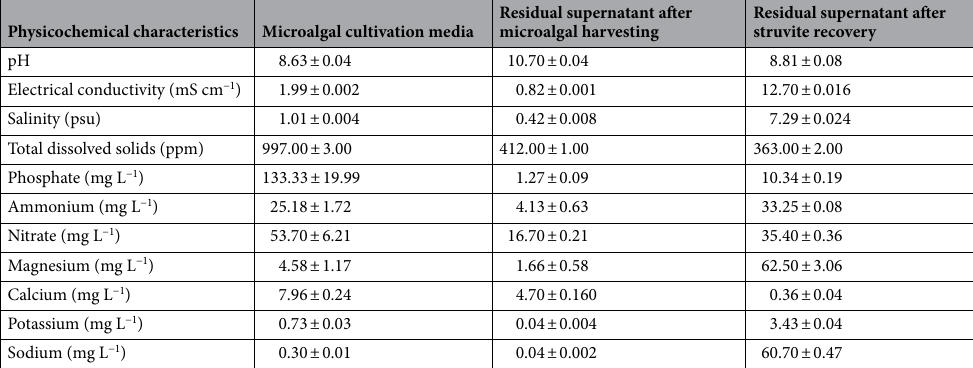
Table 2. Comparison of physicochemical characteristics of microalgal cultivation media and residual supernatants after harvesting and struvite